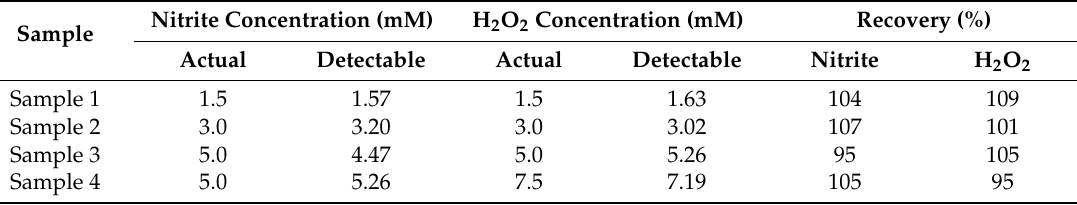
Table 3. Simultaneous electrochemical detection of nitrite and H 2 O 2 based on 3D Au-rGO/FTO.